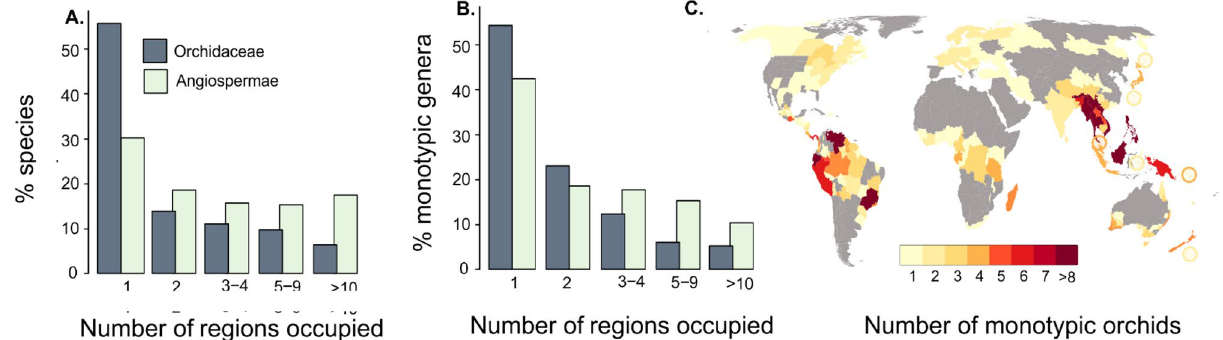
Figure 2. ( A ) Histogram showing the proportion of orchids and Angiosperm species (excluding orchids) that are located in a given number of geographic regions. ( B ) Histogram showing the proportion of monotypic orchid genera that are located in a given number of geographic regions. ( C ) World map highlighting centres of monotypic orchid species richness. All calculations, maps and other graphics were created using R 3.5.1, R Core